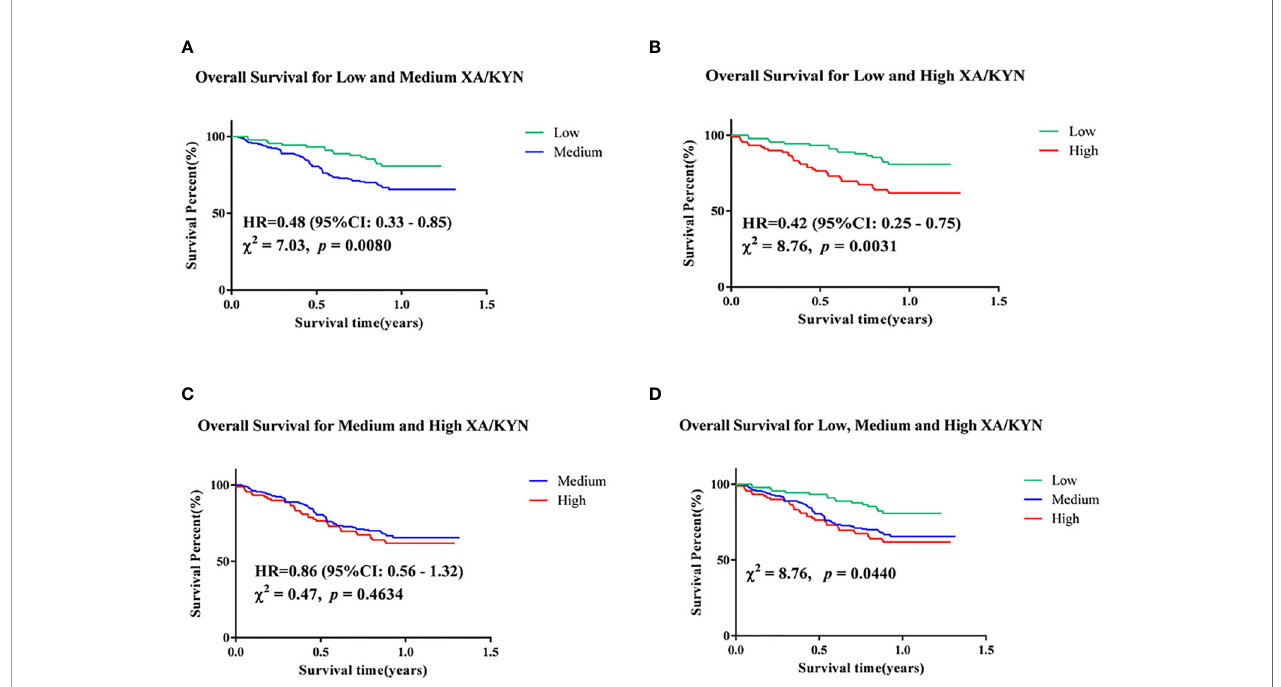
FIGURE 5 | Kapan-Meier analyses of (A) low and medium XA/KYN, (B) low and high XA/KYN, (C) medium and high XA/KYN, and (D) low, medium and high XA/ KYN for overall survival of patients. XA, xanthurenic acid; KYN,